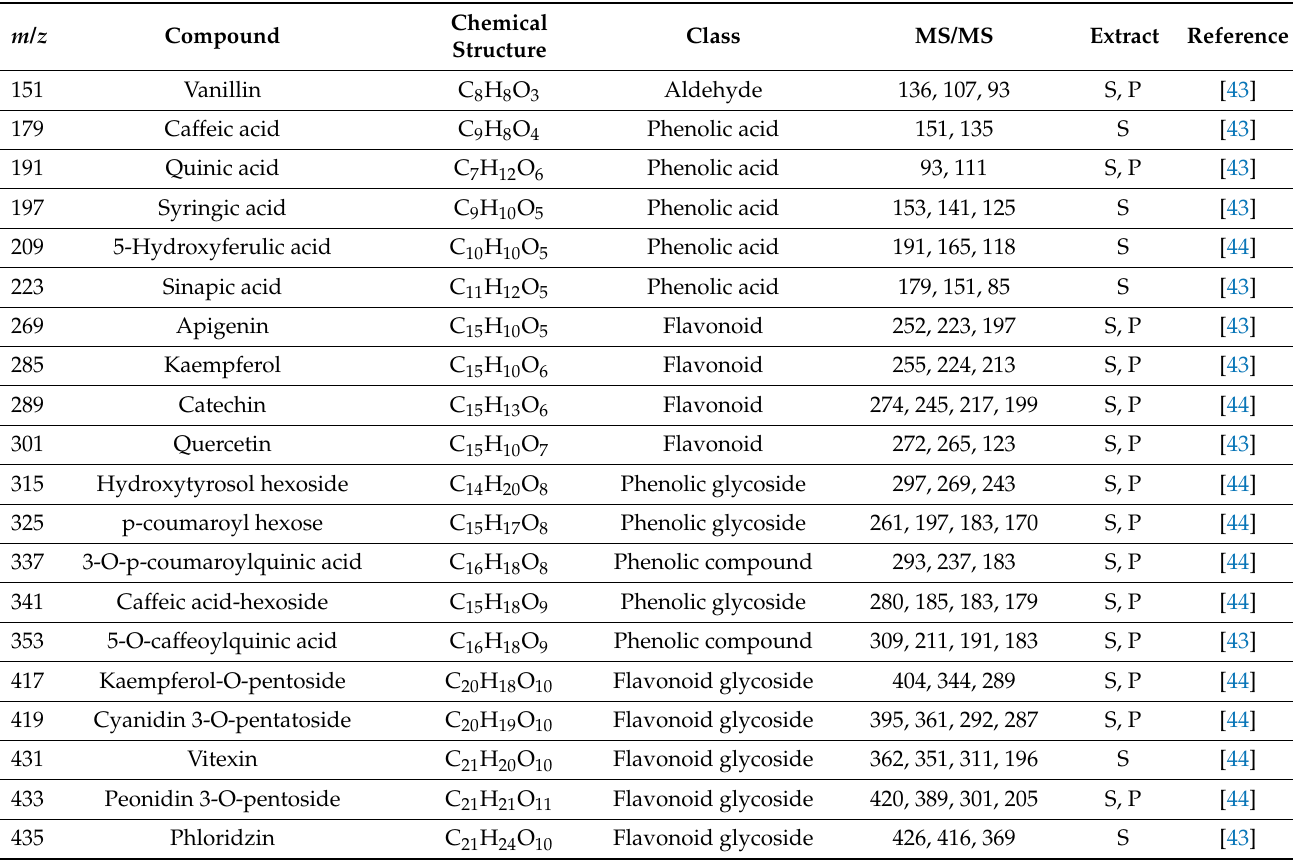
Figure 3. PS ( − ) MS full scan of ethanol extracts from seed of avocado. Table 5. Compounds tentatively identified in avocado seed and peel by ( − ) PSMS.